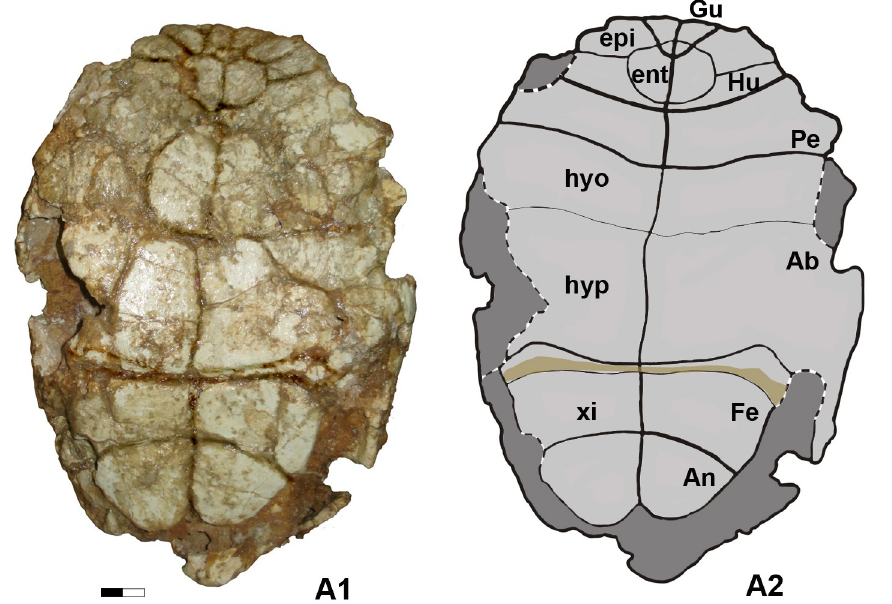
Fig 4. A1. Plastron in ventral view. A2. Interpretative